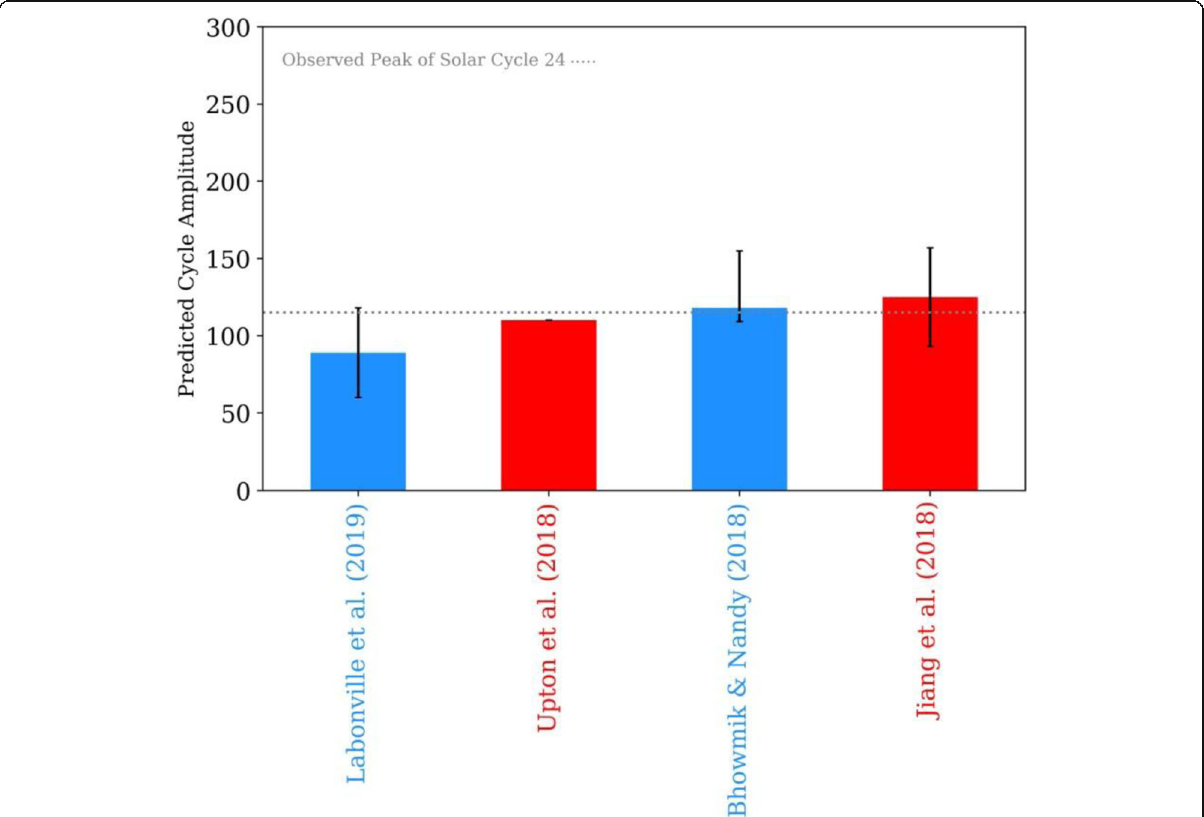
Fig. 5 A summary of physical model-based predictions for solar cycle 25 indicates that the forecasts have converged and indicates a weak cycle, similar or slightly stronger relative to the previous cycle 24. Adapted from Nandy